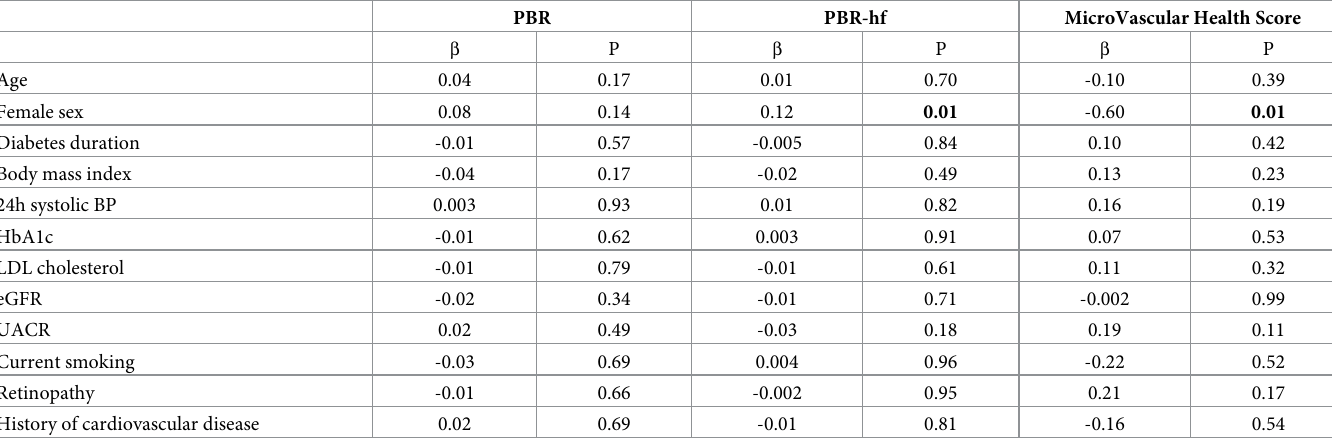
The β -estimates represent standardized effect. PBR: Perfused Boundary Region; PBR-hf: Perfused Boundary Region at a fixed high flow level; UACR: urine albumin creatinine